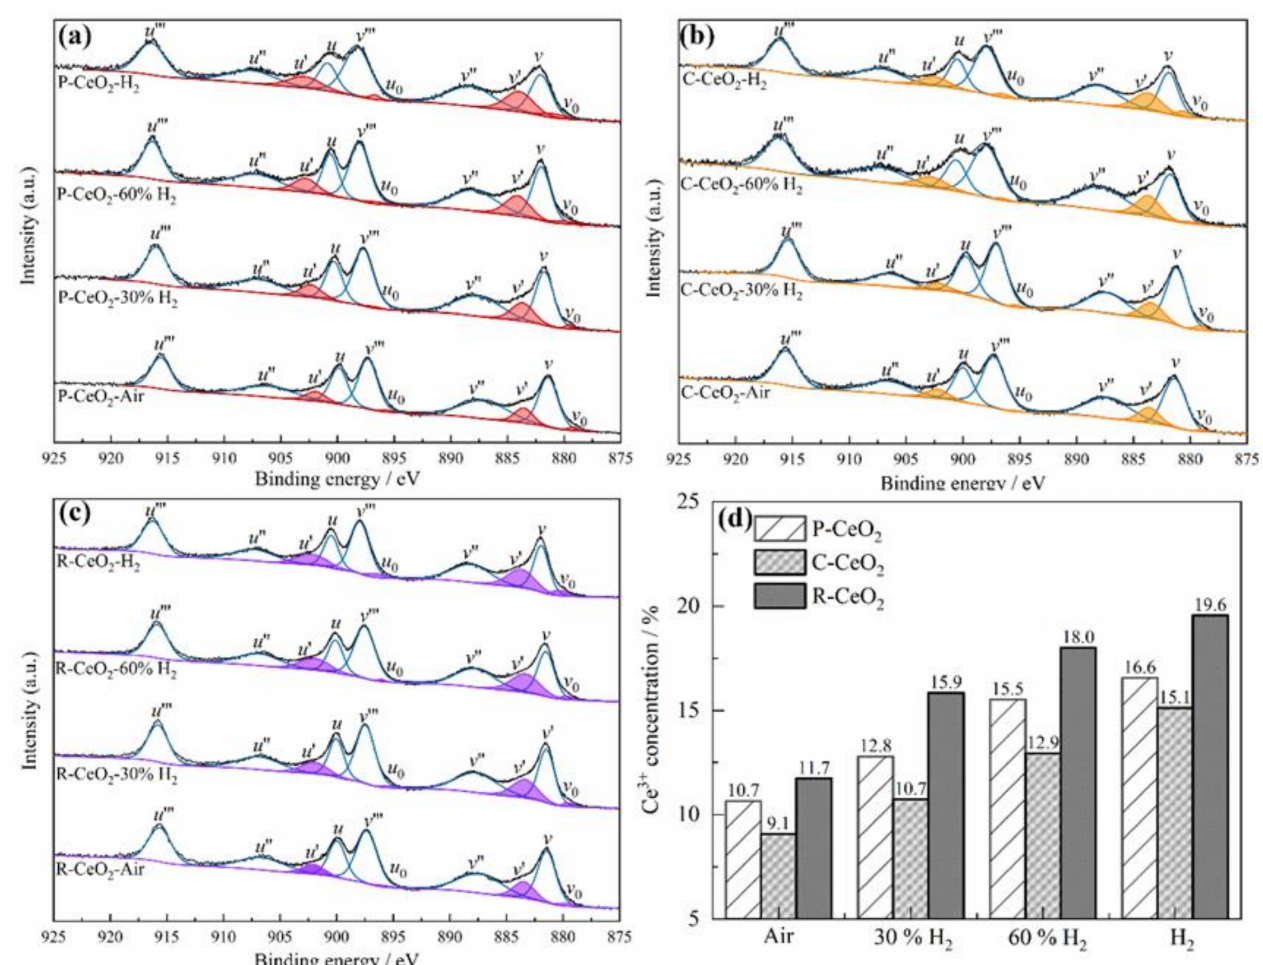
Figure 4. The XPS spectra of P-CeO 2 ( a ), C-CeO 2 ( b ) and R-CeO 2 ( c ) annealed in different concentration of H 2 , and the calculated Ce 3+ fractions ( d